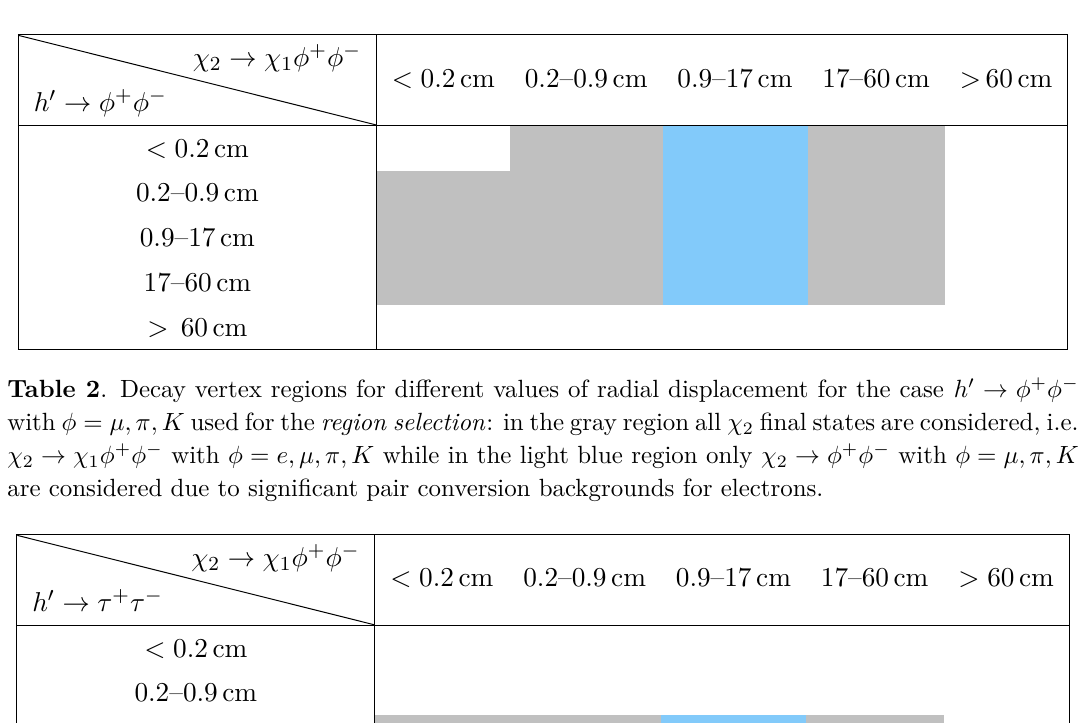
final states are considered, i.e. χ 2